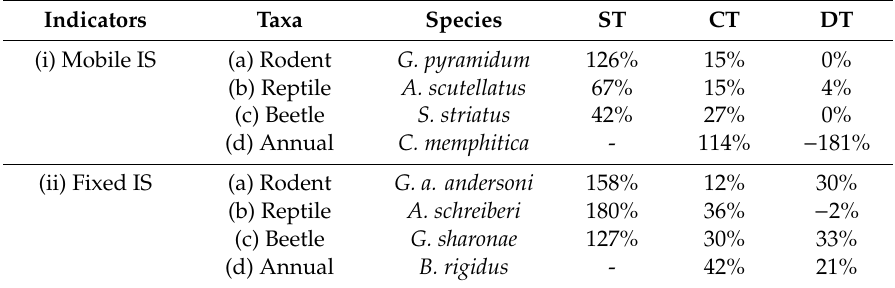
Table 2. E ff ectiveness of treated dunes on abundance of Mobile and Fixed-dune Indicator Species (IS). Calculated as the change (either increase or decrease) in abundance (faunal taxa) or % cover (annuals) from control to treated dune, as a percentage of the di ff erence in abundance between control and reference dunes for each